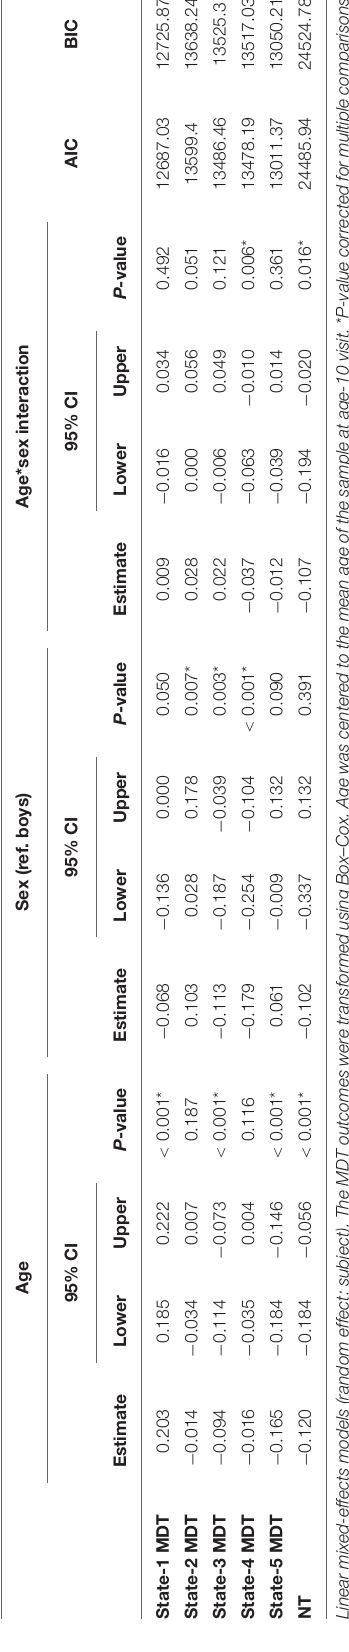
TABLE 4 | Sex stratified age-associations with transformed mean dwell time (MDT, number of time windows) in state-4 and number of transitions (NT) between states.